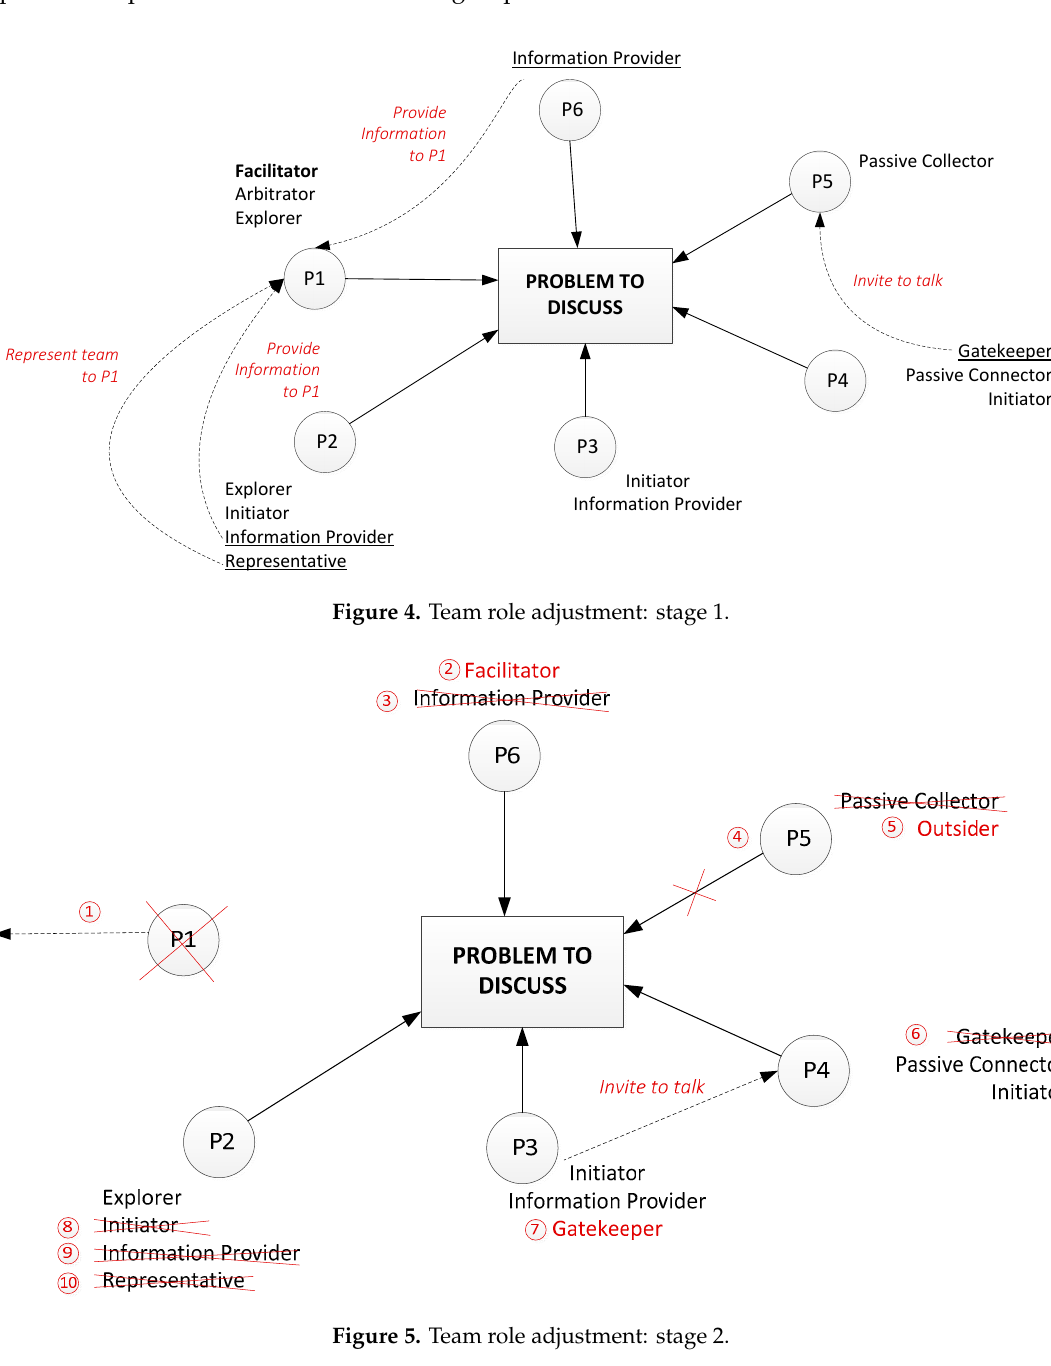
Figure 5. Team role adjustment: stage 2.